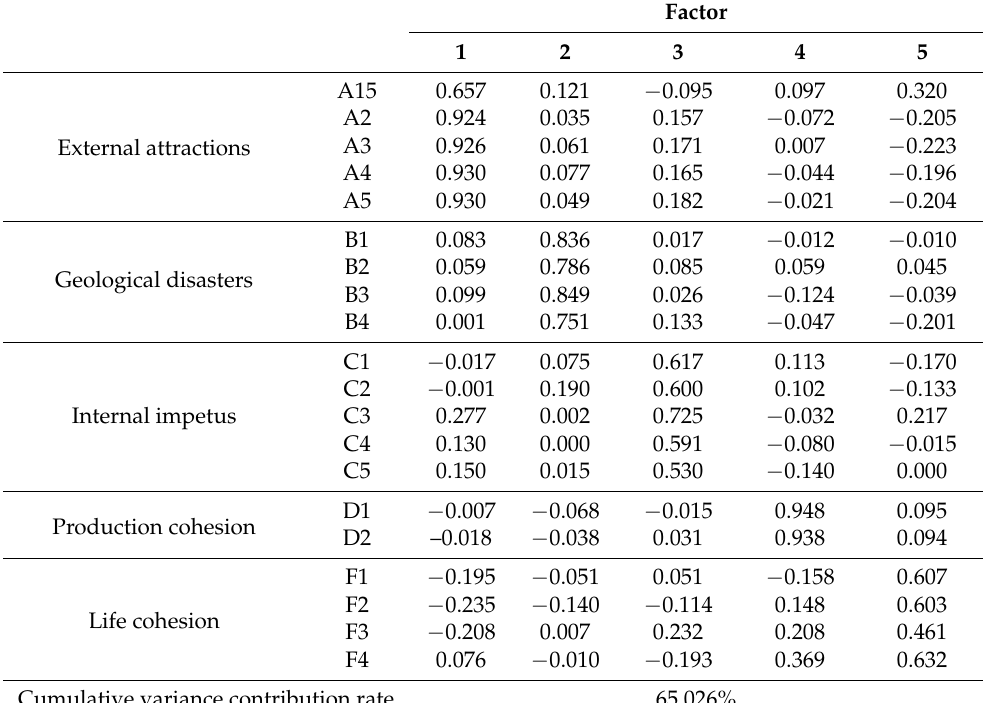
Table 4. Factor loading matrix after